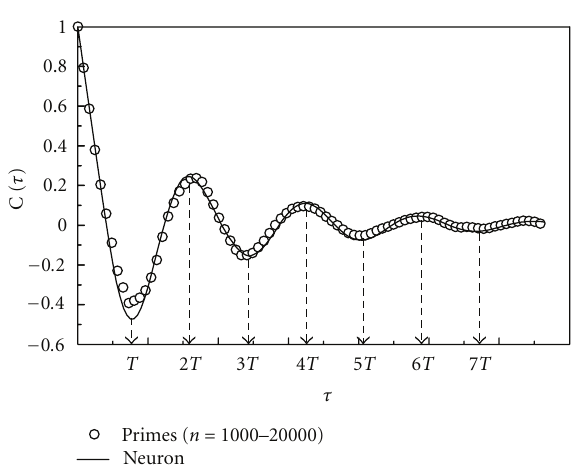
Figure 8: As in Figure 7 but for interval 1000 < n < 2 × 10 4